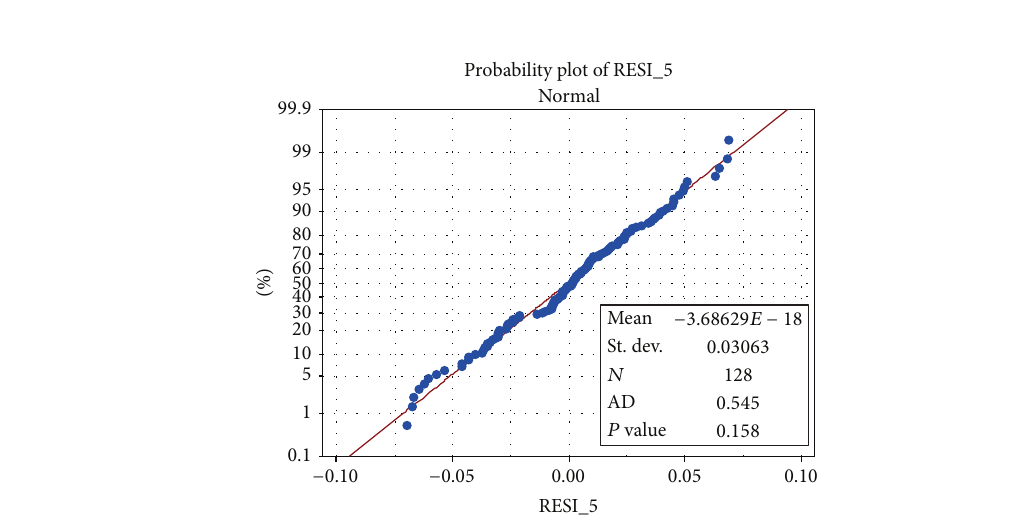
Figure 6: Anderson-Darling normality test results for 𝑅 𝑎